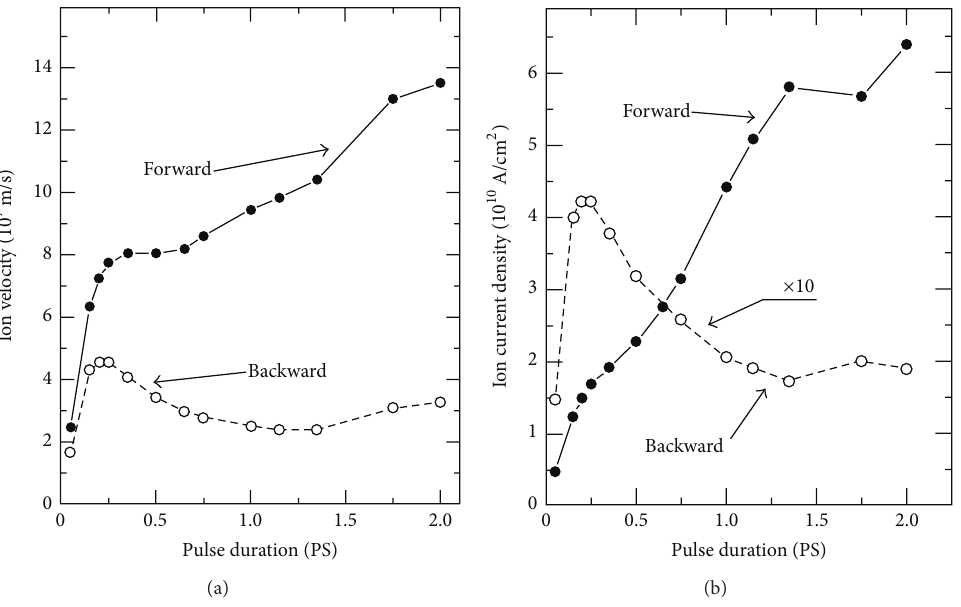
Figure 6: The maximum ion velocities (a) and the maximum ion current densities (b) as a function of the laser pulse duration. 𝐼 𝐿 = /𝜆 = 1 10 17 W/cm 2 , 𝐿 𝑛